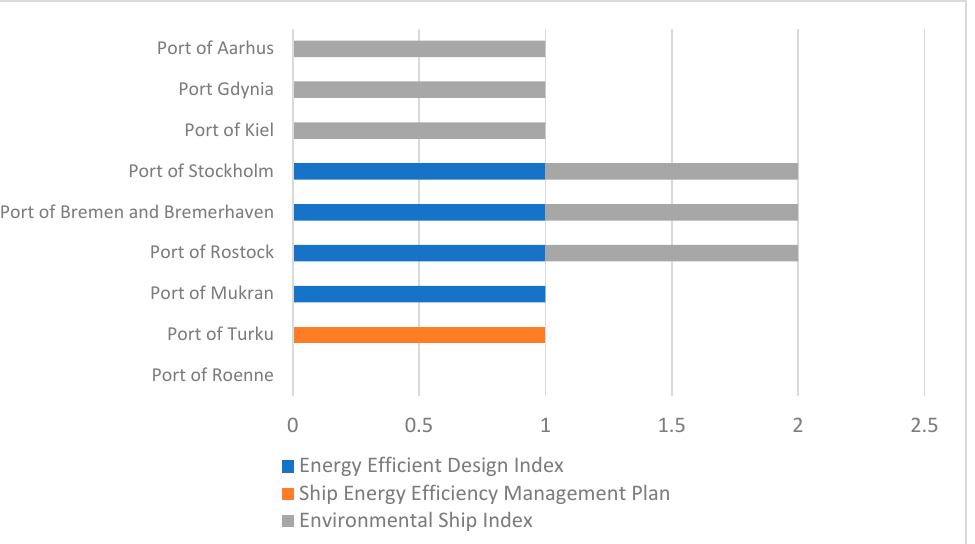
Figure 3. Monitoring of energy efficiency measures and other indicators in the surveyed maritime ports of Northern Europe. Source: own study.